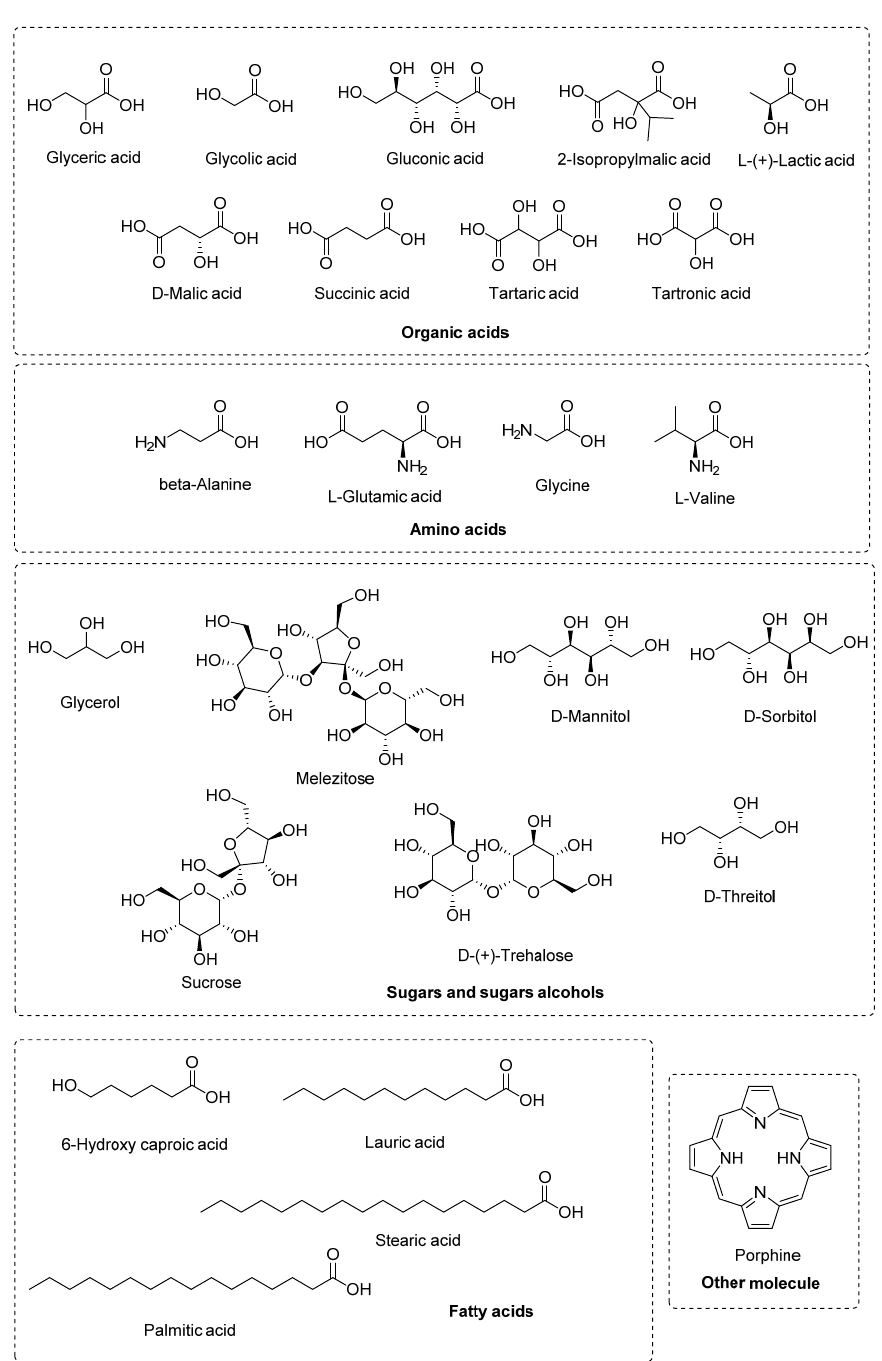
Figure 3. Conspicuous chemicals of the methanolic extract of the flowers of C. maxima.